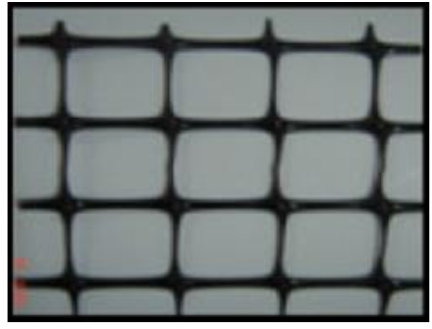
Figure 4. Polyethylene (Tensar)